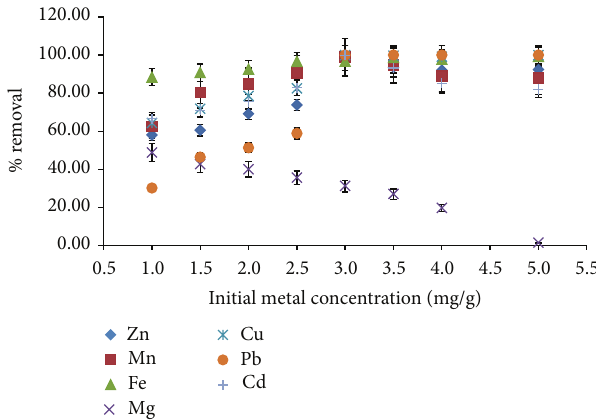
Figure 9: Effect of initial metal concentration on metal removal by MNS.